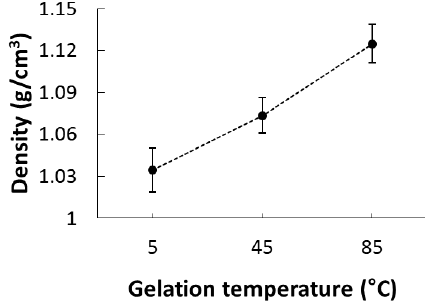
Figure 7. Density (g/cm 3 ) of CAG beads prepared at different gelation temperatures.